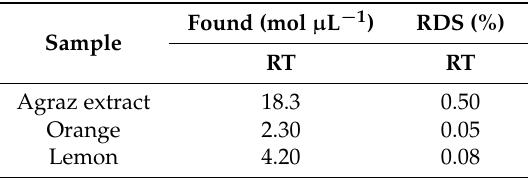
Table 3. Results for RT in tropical fruit